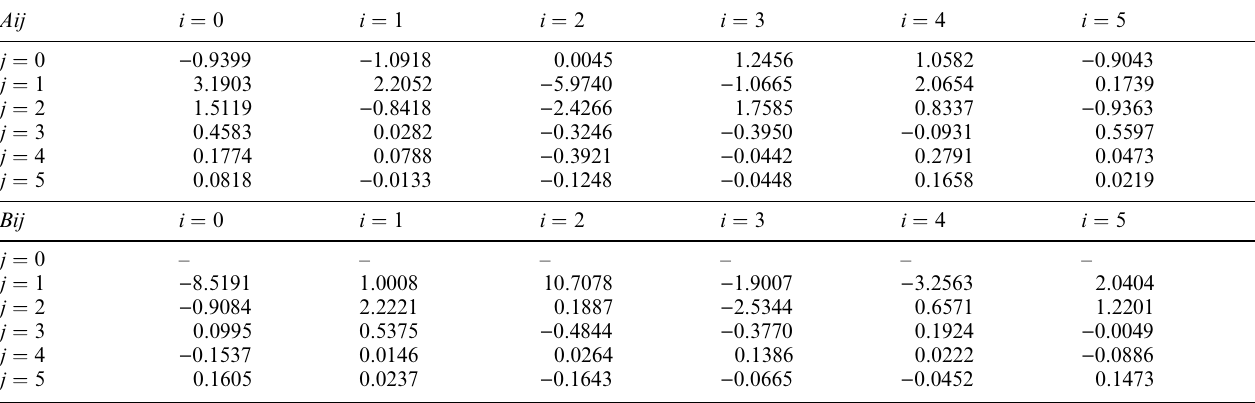
Table 1. Coefficients of the theoretical functions fitting the potential (cid:47) between 62 (cid:176) and 89 (cid:176) invariant latitude for 2 < Kp < 4